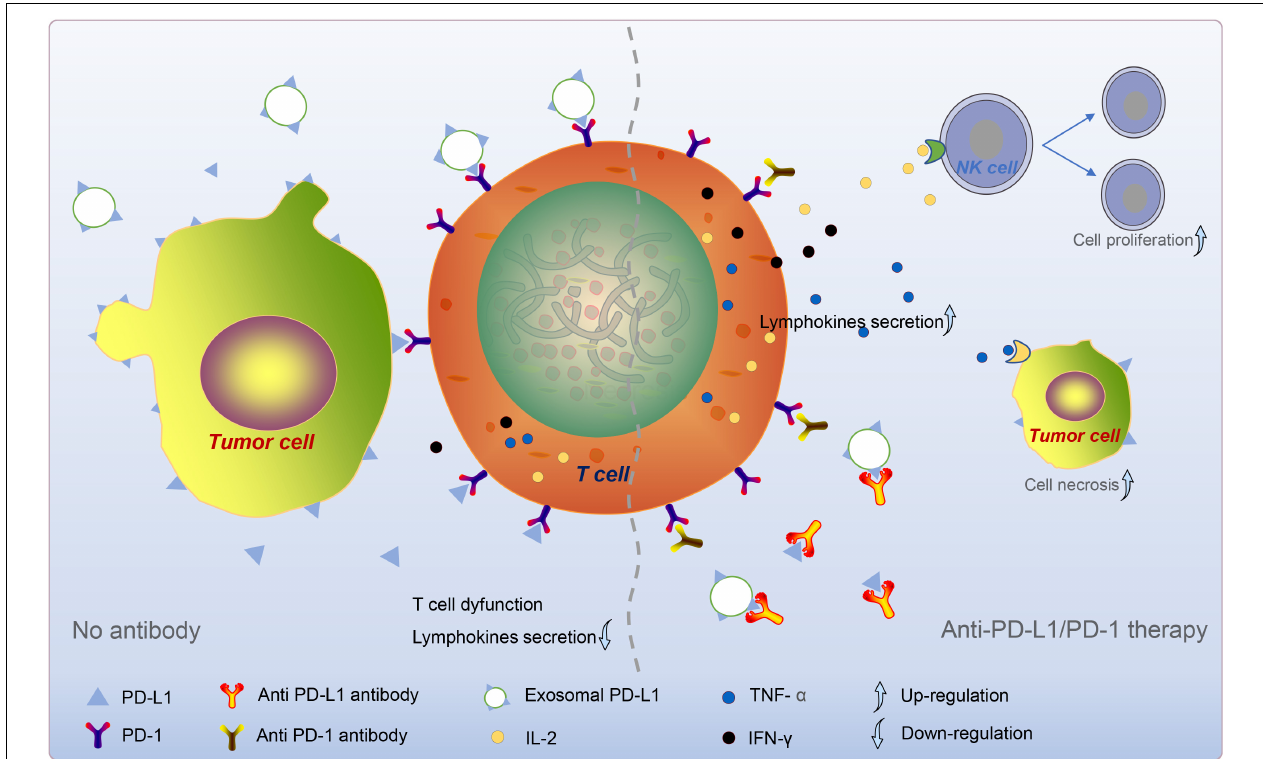
FIGURE 2 | Tumor cell-derived exosome PD-L1-mediated immune escape. Exosome PD-L1, which synergizes with sPD-L1 and PD-L1 on the surface of tumor cells, binds to PD-1 on T cells and reduces T cell activity and lymphokine secretion. In anti-PD-L1/PD-1 therapy, the antibody specifically binds to PD-L1/PD-1, prevents the coupling of circulating PD-L1 to PD-1, increases the secretion of cytokines. Subsequently, these cytokines, such as IL-2, TNF- α , and IFN- γ , could give rise to the division and proliferation of NK cells and the death of tumor cells. The dotted line divides the picture into left and right sides. The left part mainly describes the “No antibodies” situation, and the right part mainly talks about the “anti-pd-1/PD-L1 therapy” situation.